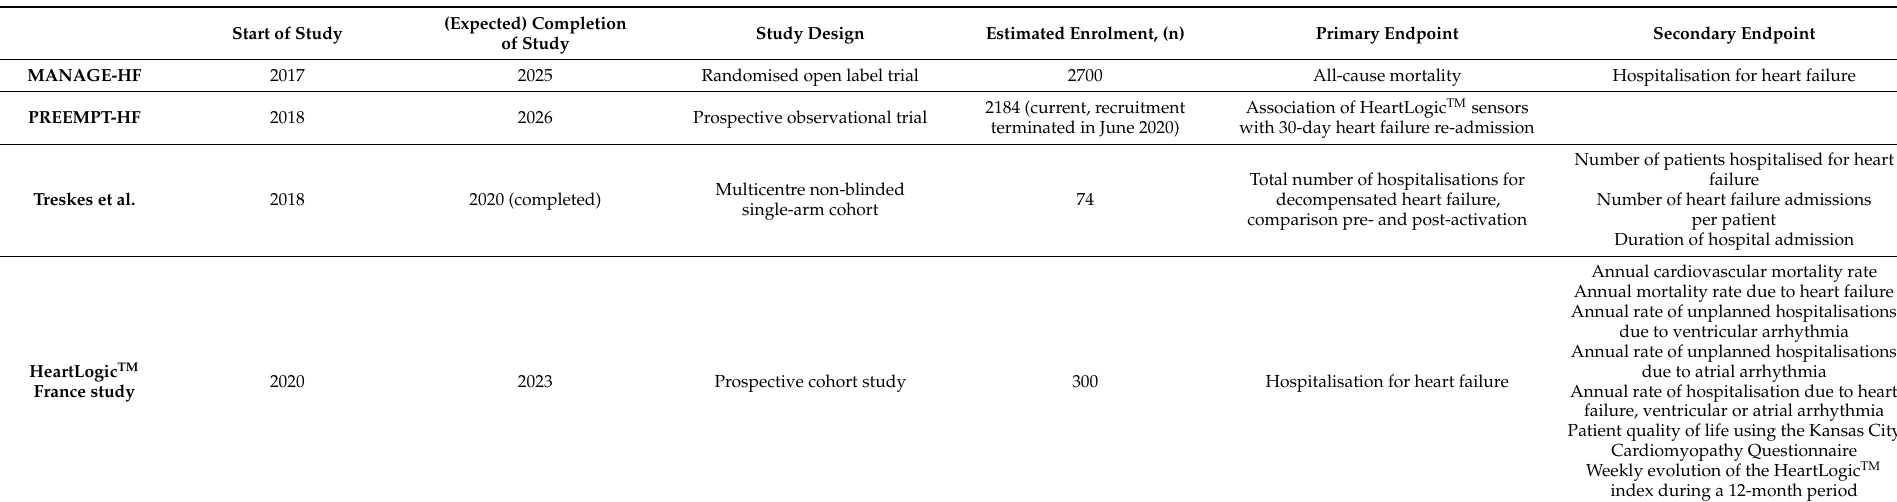
Table 2. Overview of the study characteristics of the 4 ongoing